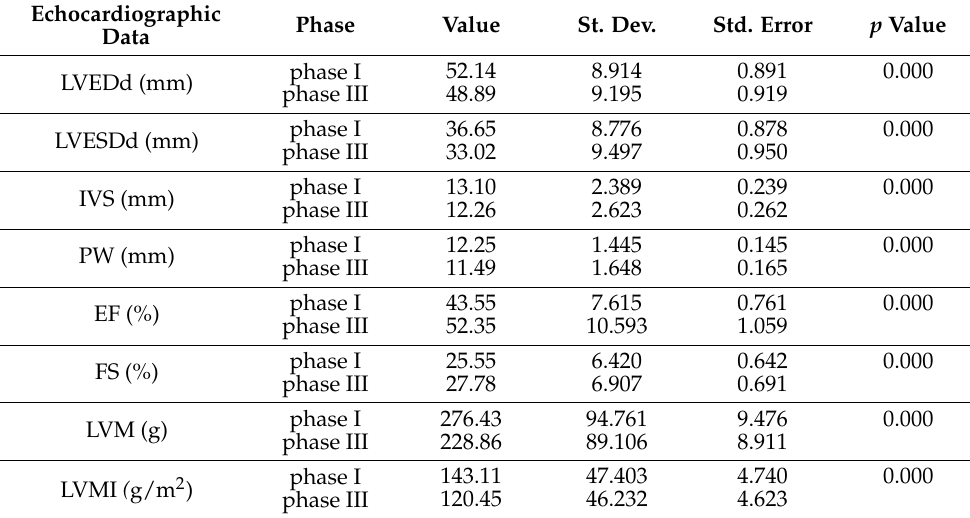
Table 2. Echocardiographic results in the two studied phases ( N = 120).